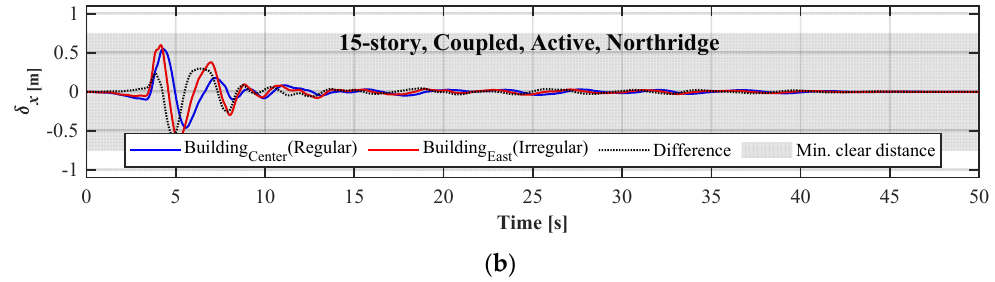
Figure 16. Top floor displacements of two coupled buildings on a rock base with uncontrolled, ( a ), active control algorithm, ( b ).